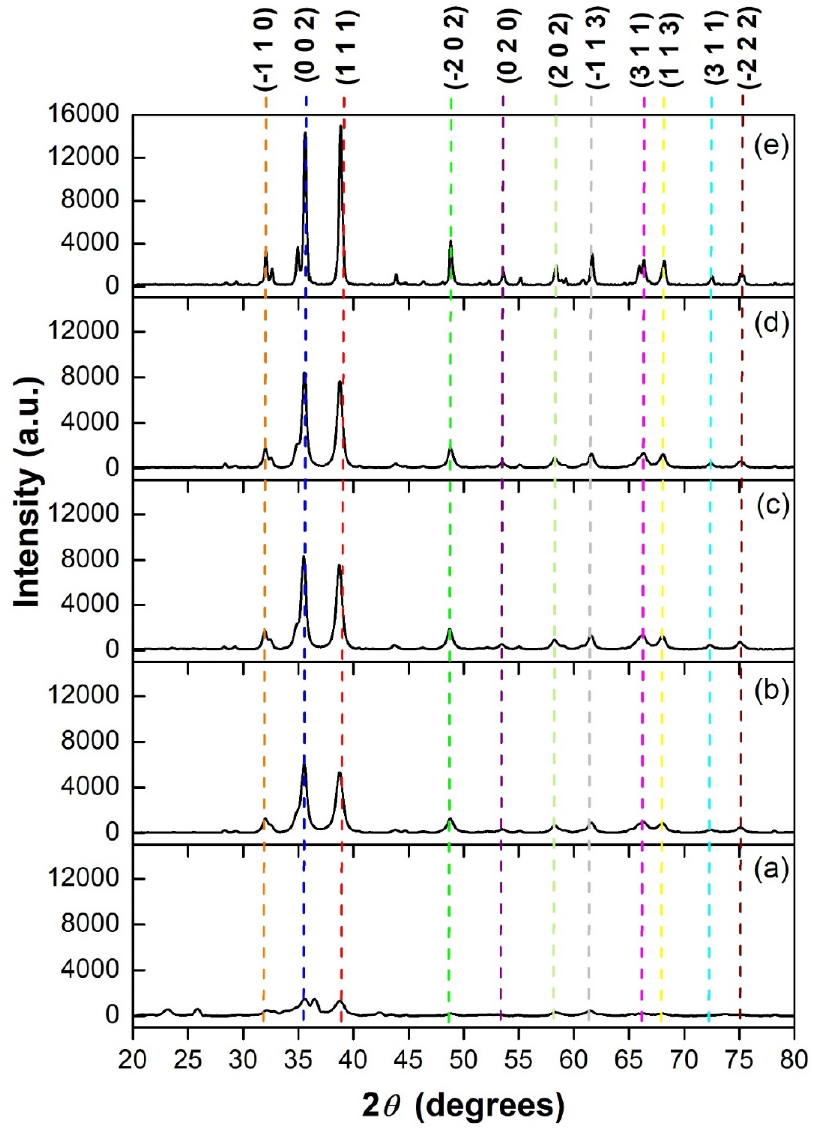
Figure 5. XRD pattern of G. mangostana L. leaf extract-mediated synthesized CuO NPs at ( a ) 200 ◦ C, ( b ) 300 ◦ C, ( c ) 400 ◦ C, ( d ) 500 ◦ C and ( e ) 600 ◦ C calcination temperatures. The purity and chemical composition of the mangosteen leaf extract mediated-CuO NPs calcinated at 500 ◦ C was investigated by XPS and shown in Figure 6. As the high- resolution XPS spectrum shows in Figure 6b, the Cu 2 p core level shows two peaks at 933.56 and 953.81 eV and indicates the detection of Cu 2p 3/2 and Cu 2p 1/2 , respectively,